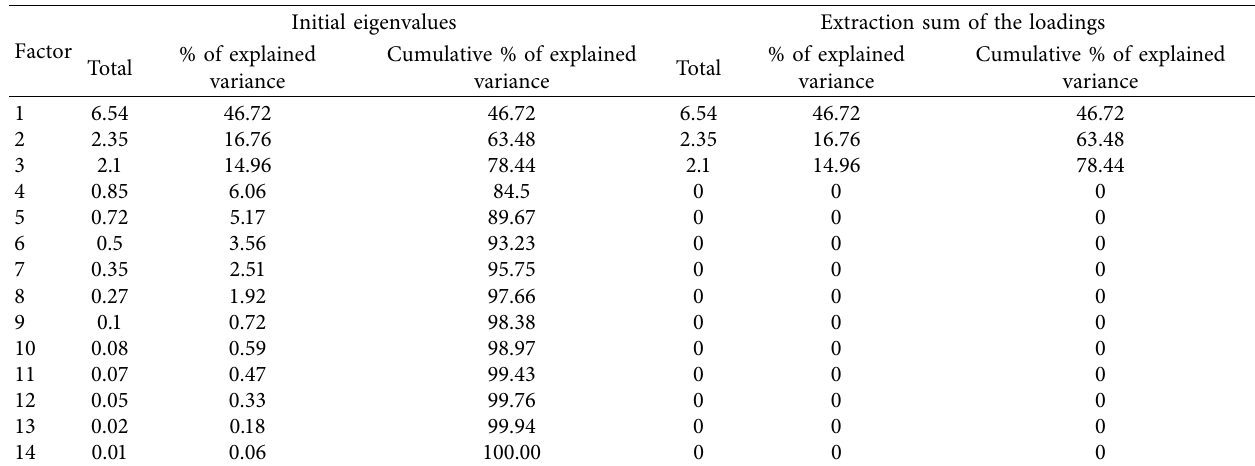
Table 6: PCA of the 14 compounds and total explained